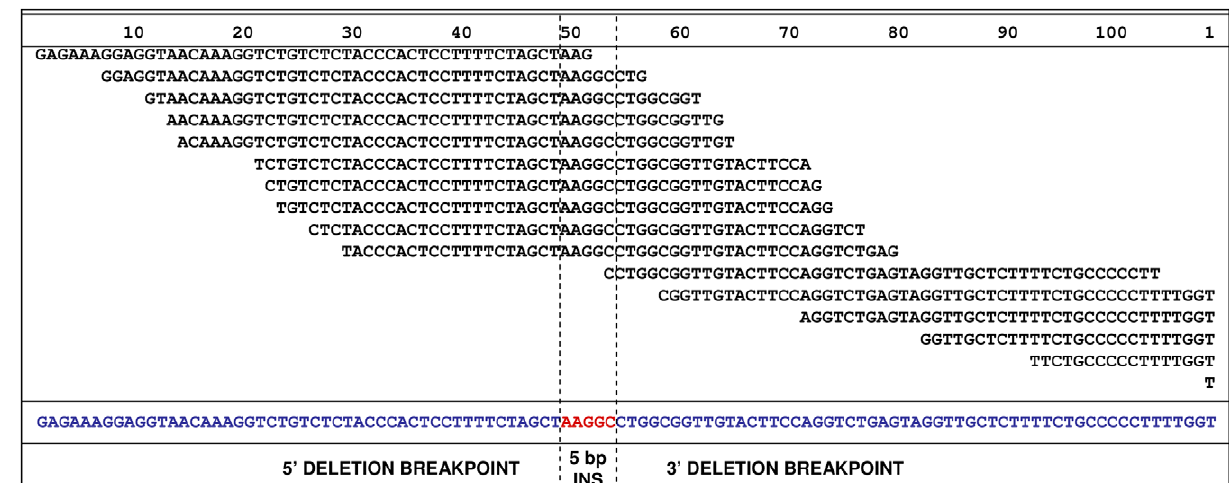
Figure 3. Denovo assembly of reads, from a single EF case, aligned across the deletion.